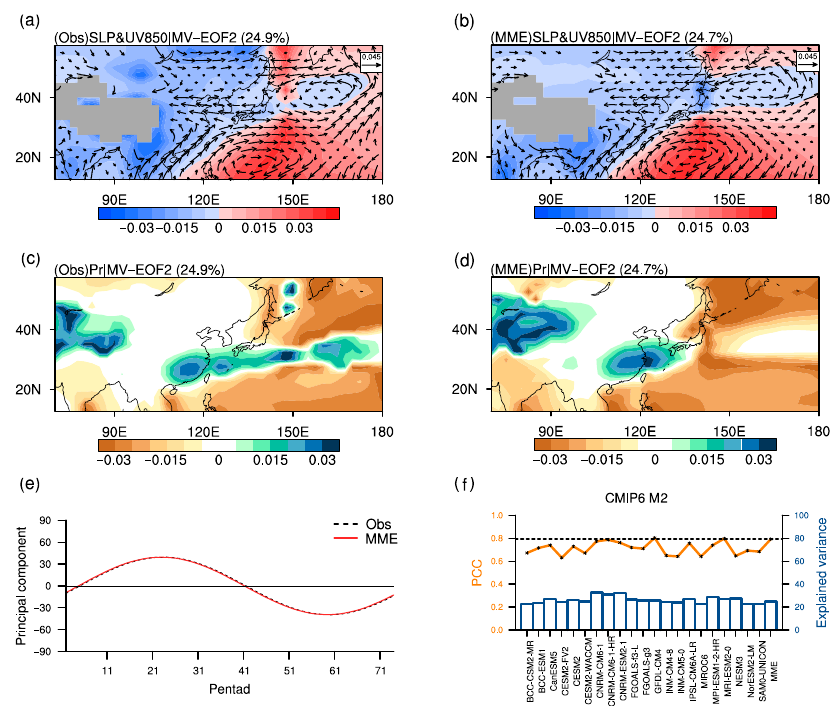
Figure 5. Second annual cycle mode (M2) from MV-EOF2 in ( a , c ) OBS and ( b , d ) MME. ( a , b ) show the spatial structures for the SLP and 850-hPa horizontal wind anomalies and ( c , d ) for precipitation anomalies. The explained variance of M2 is 24.9% in observation and 24.7% in MME simulation. ( e ) PC time series of MV-EOF2. The black trigonometric function curve indicates the observation, and the red one indicates the MME mean. ( f ) Explained variances (blue bar) of MV-EOF2 in individual models and the MME mean. The orange curve indicates the multivariate pattern correlation coefficients between the MV-EOF2 spatial pattern in OBS ( a , c ) and models (such as ( b , d ) for MME). The black dashed line indicates the MME PCC.